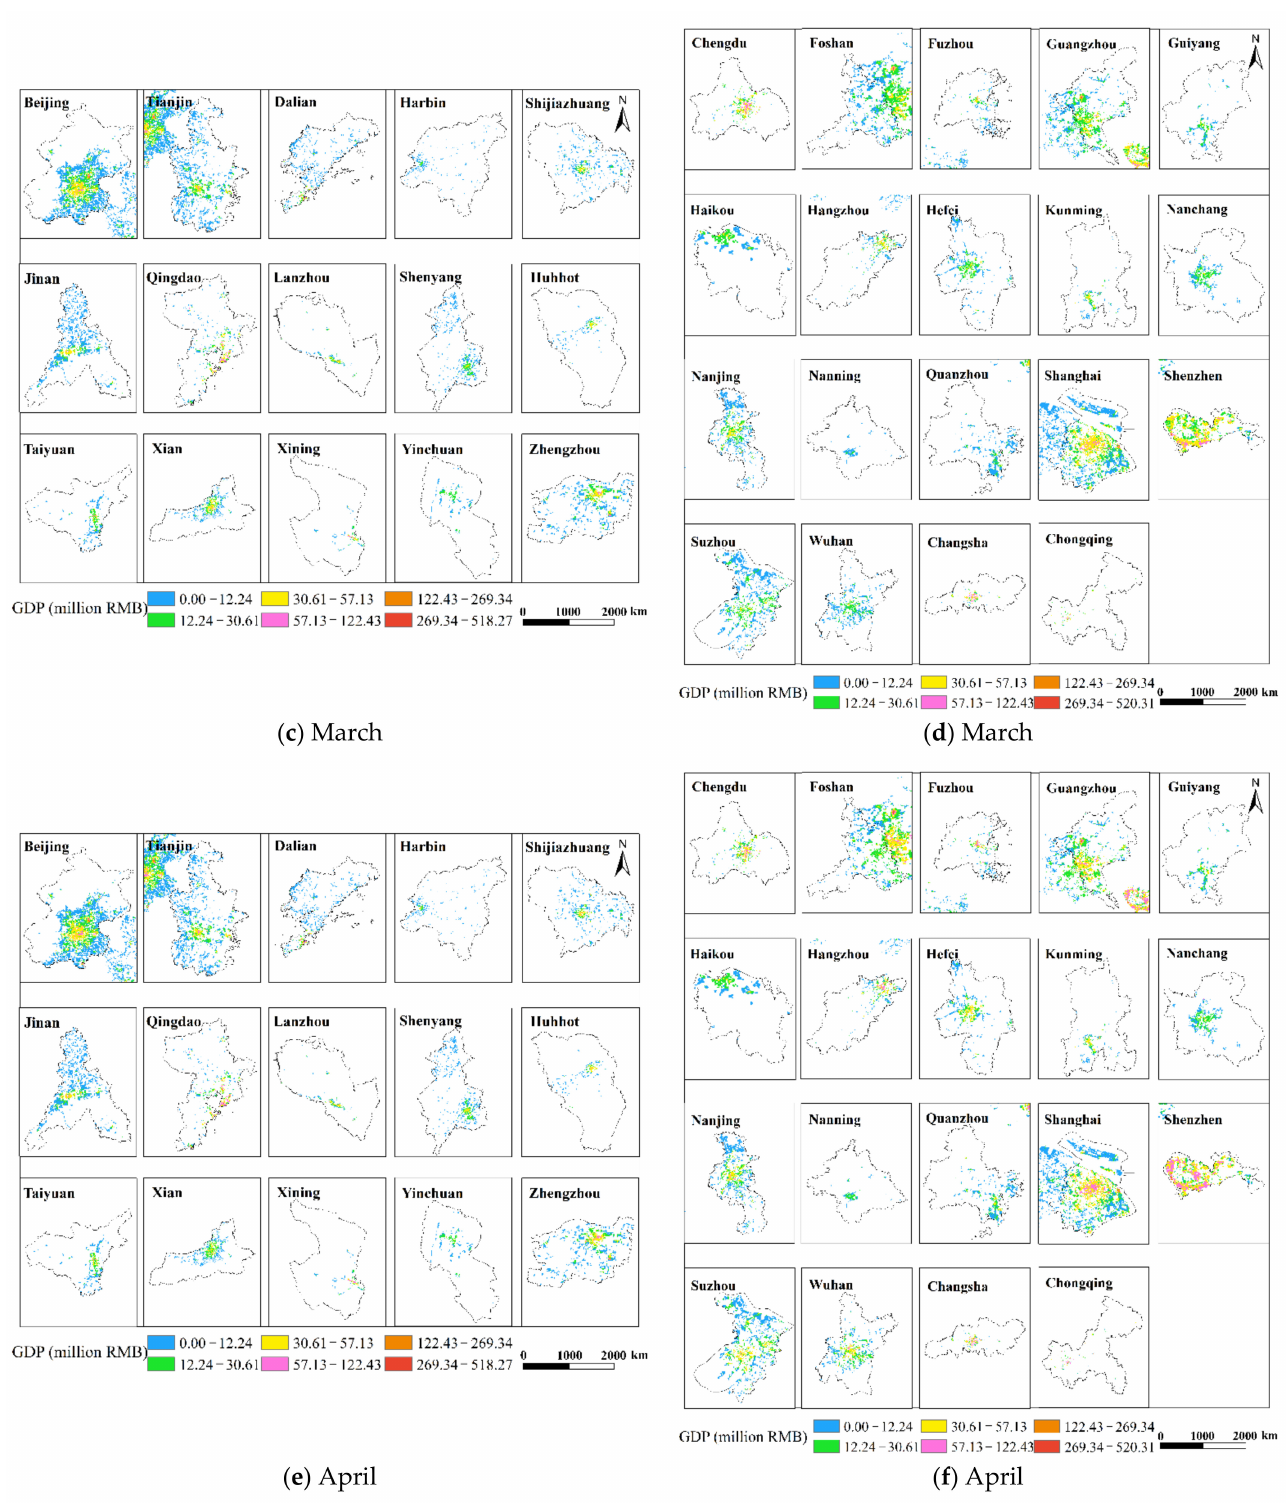
Figure 7. The spatialization of GDP of 34 cities in the tertiary industry from February to April